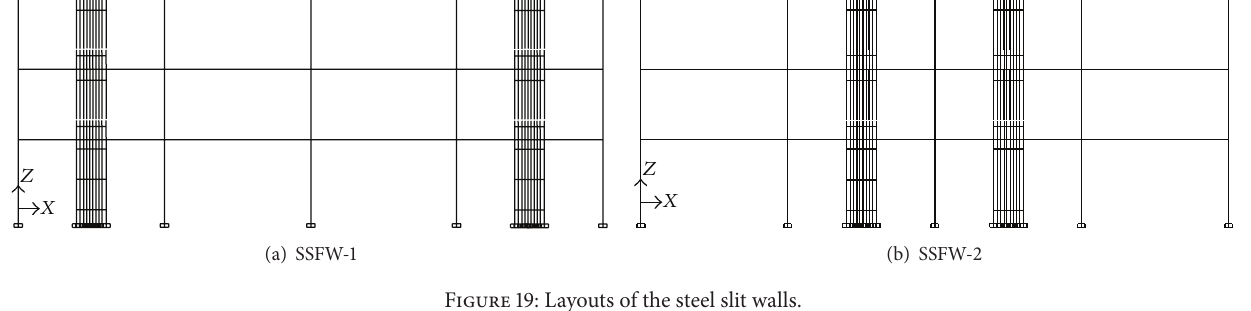
Figure 19: Layouts of the steel slit walls.